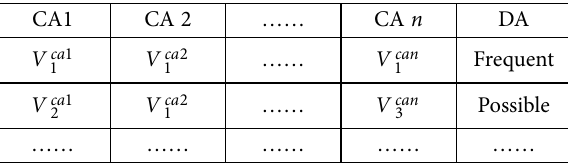
Table 6. Information system of safety risk